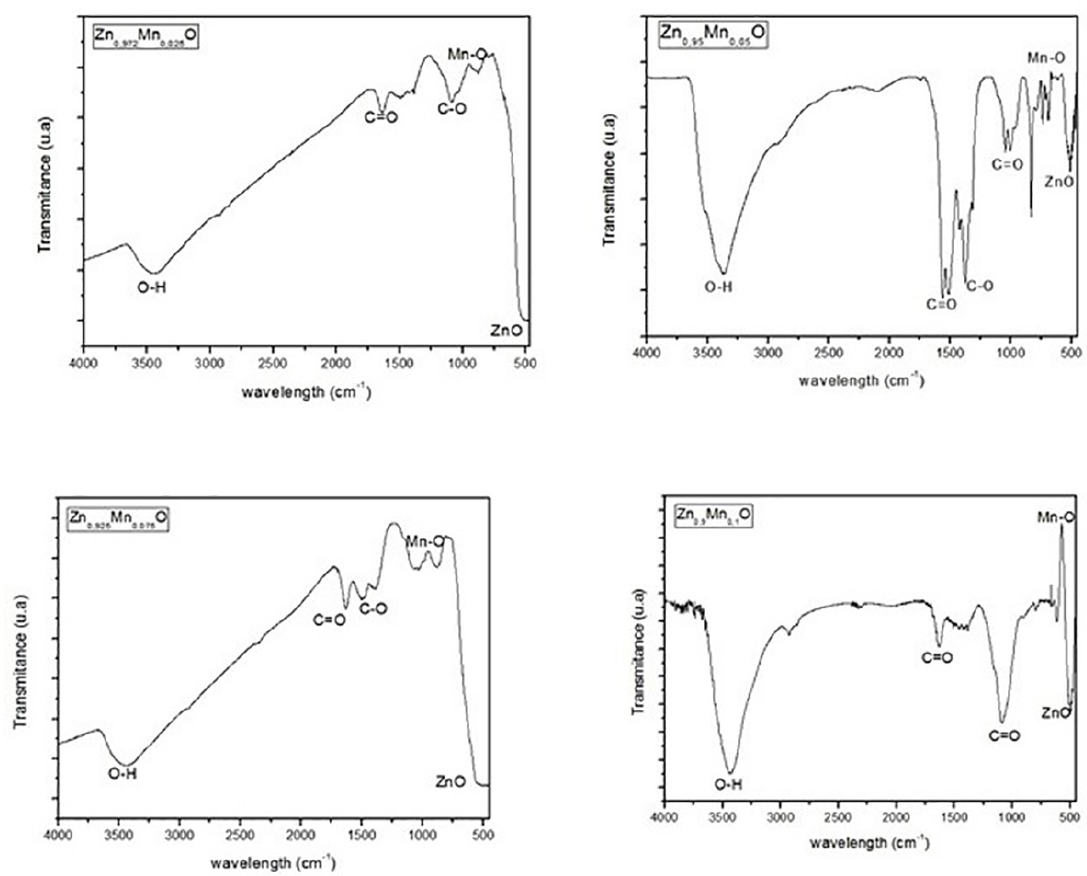
Mn O (x = 0.025, 0.05, 0.075 and 0.1). 1-x x